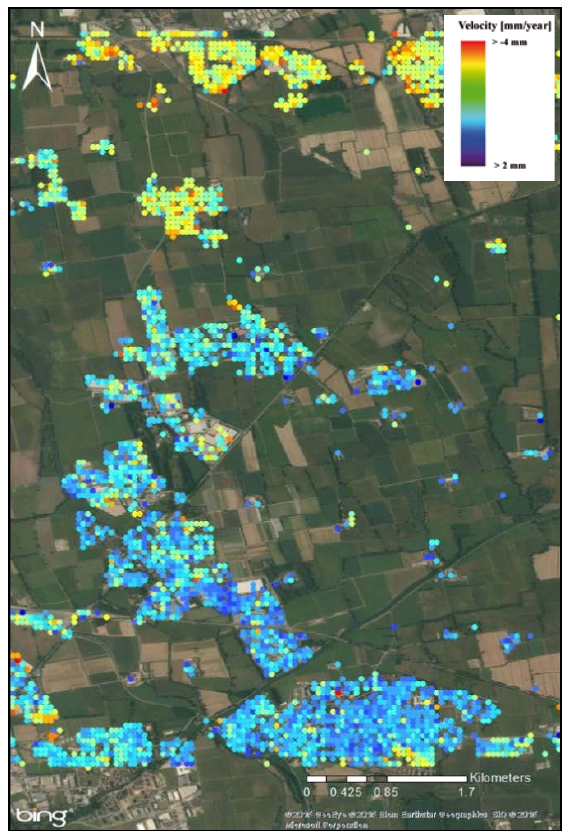
Figure 3. Permanent scatterers in the test area